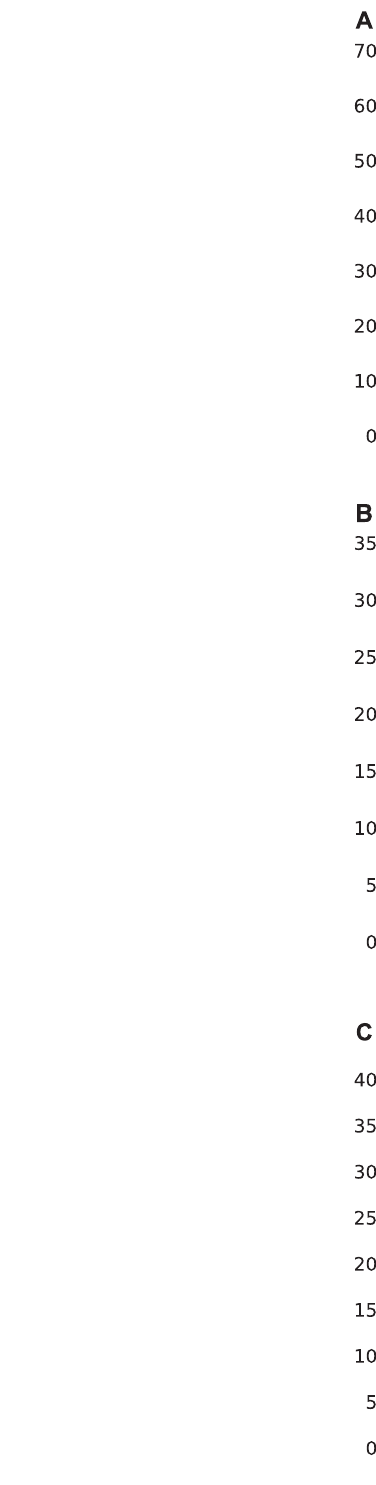
Frontiers in Earth Science |